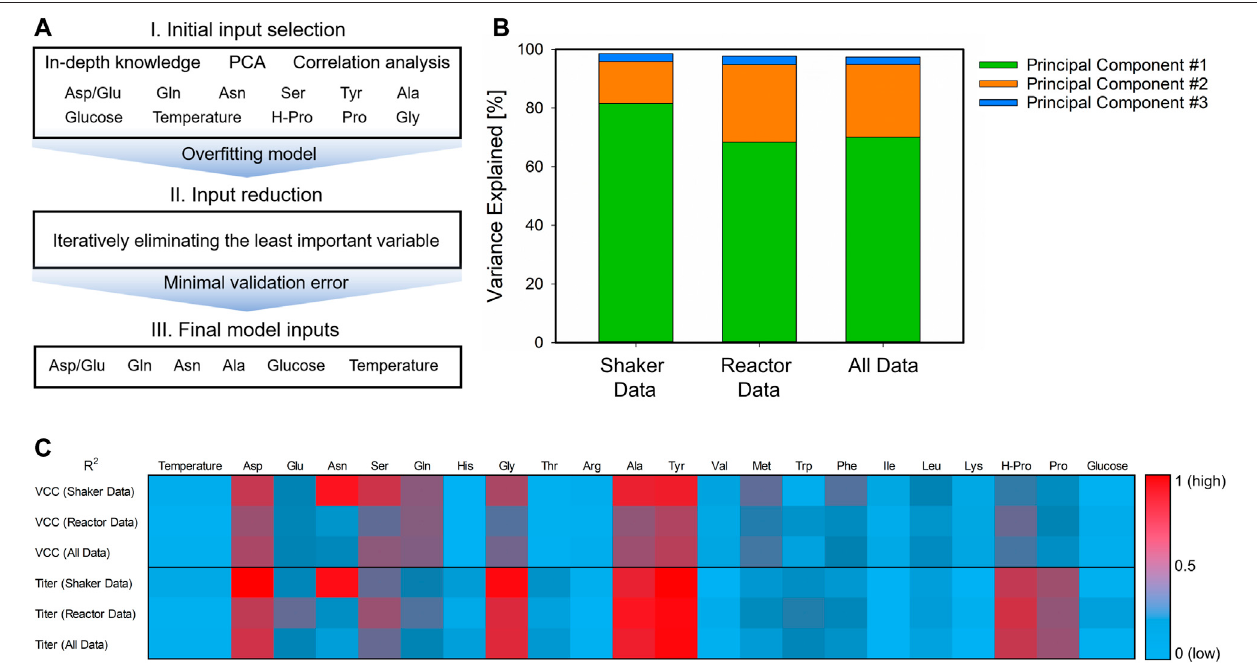
FIGURE 3 | Work fl ow for the identi fi cation of the fi nal hybrid model inputs. Starting with an initial input selection derived from availability and in-depth knowledge, unsupervised learning, and correlation to model targets (A, I) , the complex over fi tted model was simpli fi ed by eliminating the least important variable (A, II) until the minimal validation error is found and the fi nal model inputs were identi fi ed (A, III) . The detailed results for the PCA (B) and the correlation heatmap of the target variables (C) arepresentedforthedifferentdatasets.ForPCA,theexplainedvarianceforeachprincipalcomponentisgivenasstackedbars,andtheR 2 isindicatedfromlow (0, blue) to high (1,